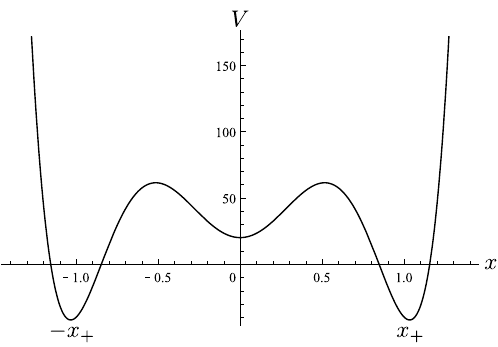
Figure 1 . The sextic potential V ( x ) [eq. (3.16)] with (cid:12) = 20, which has two global minimum at x = (cid:6) x + and a local minimum at x =